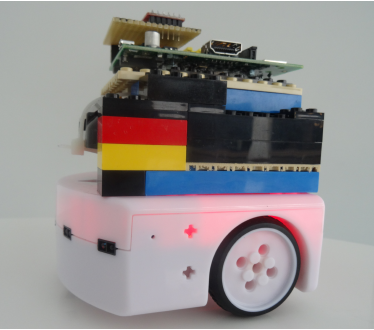
Figure 5: Thymio II robot with a Raspberry Pi and an ambient light sensor attached on